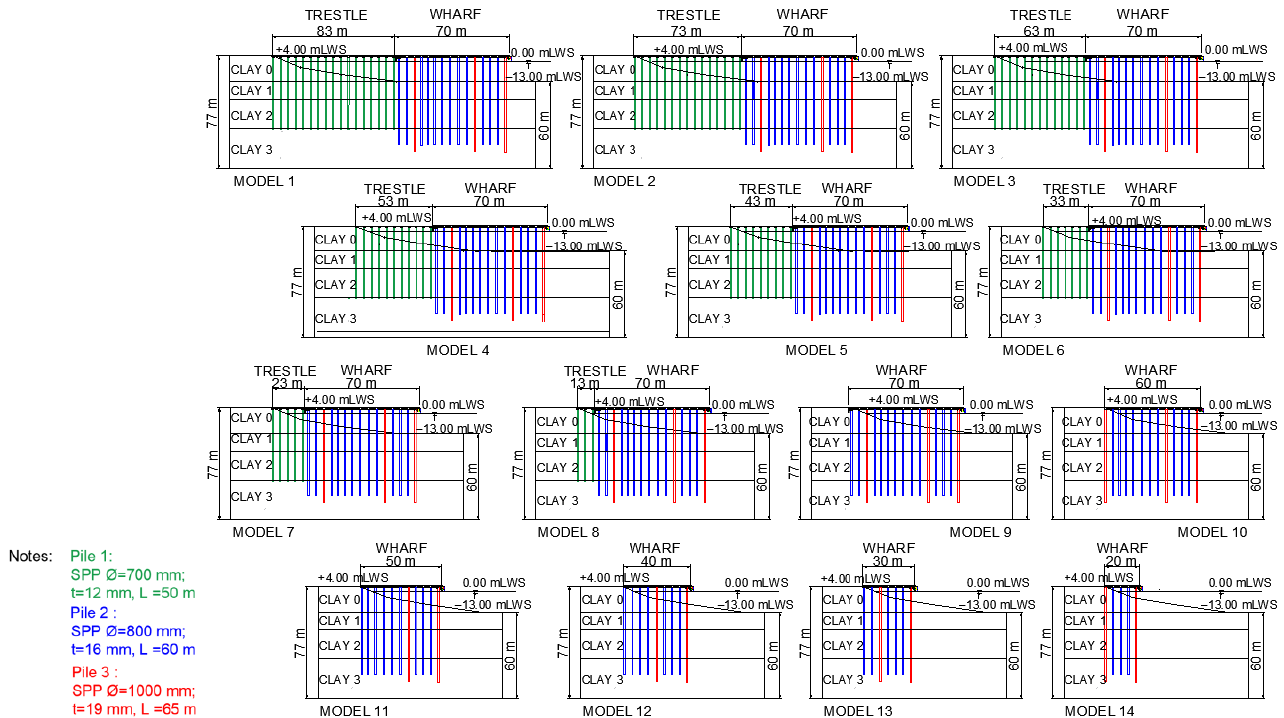
Figure 2 . Scenario 2 (with a soil slope) pile-supported wharf configurations. Figure 2. Scenario 2 (with a soil slope) pile-supported wharf